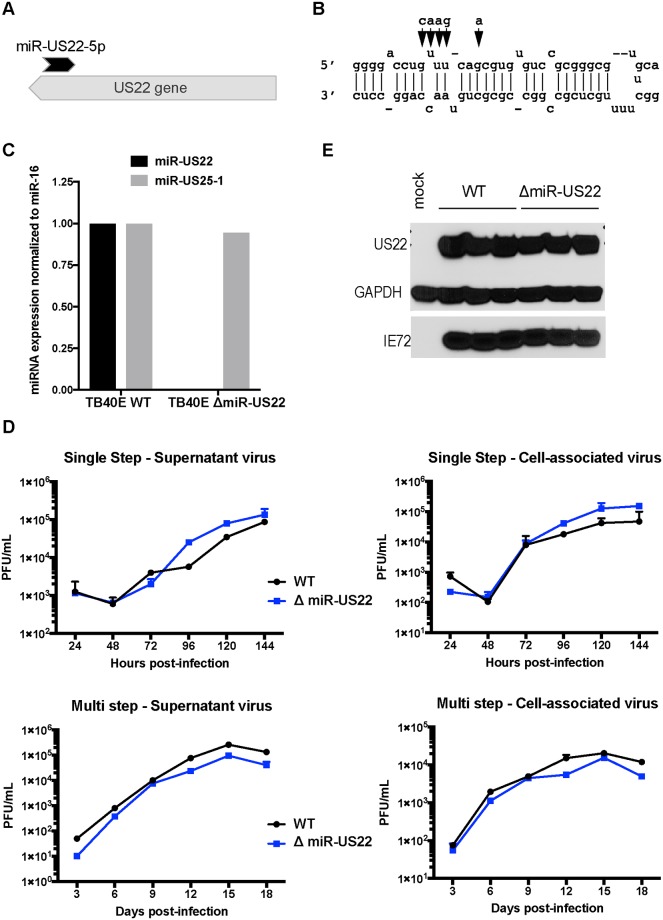
Characterization of TB40E miR-US22 mutant virus.(A) Relative location of miR-US22 within the US22 gene. (B) Introduction of point mutations (arrows) in TB40E to disrupt miR-US22 hairpin formation. (C) Loss of miR-US22 expression in NHDFs infected with the TB40E ΔmiR-US22 virus. NHDFs were infected with either WT TB40E or ΔmiR-US22 virus (MOI = 3), and miRNA levels were determined 4 days post infection by stem-loop specific RT-PCR. miR-US25–1 expression is shown as a control. (D) Mutating miR-US22 in TB40E has no effect on viral growth in fibroblasts. NHDF were infected in duplicate with either WT TB40 (black circles) or TB40E ΔmiR-US22 (blue squares) at MOI = 3 for single step or MOI = 0.05 for multi step. Plaque forming units (pfu) / mL were quantified from samples collected at the indicated time points for supernatant virus and cell-associated virus (E) The point mutations in miR-US22 do not affect US22 protein expression. NHDFs were infected with either WT TB40E or ΔmiR-US22 TB40E, and protein lysates were collected 4 days later for IB analysis. 3 replicates are shown.